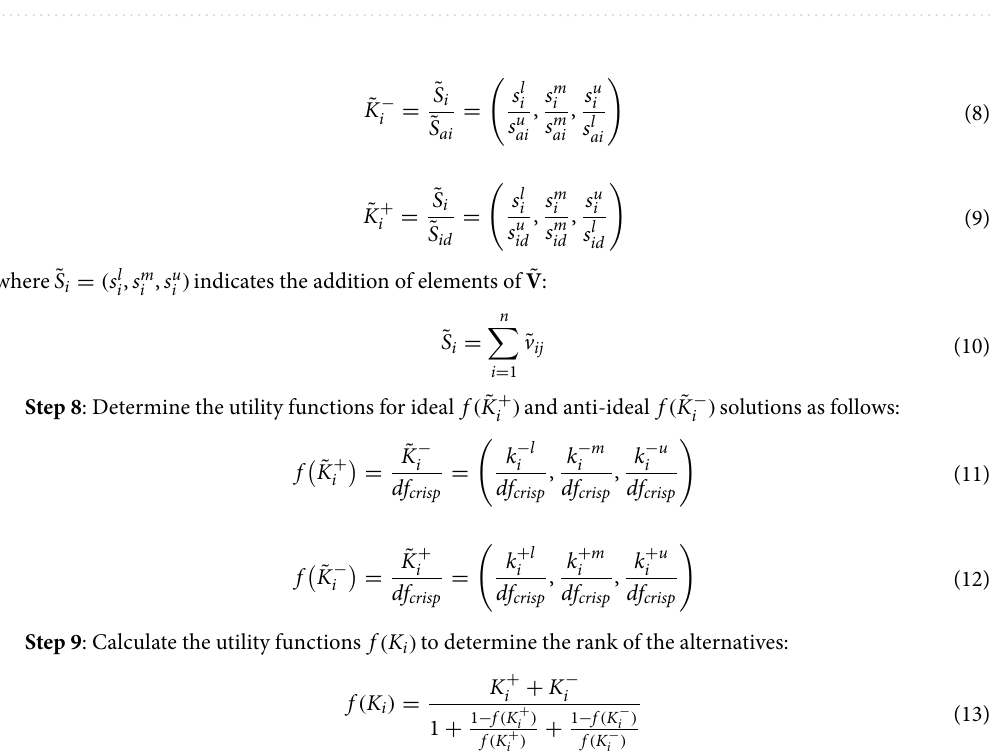
Figure 3. Growth rate of wind energy and solar energy scale in HM